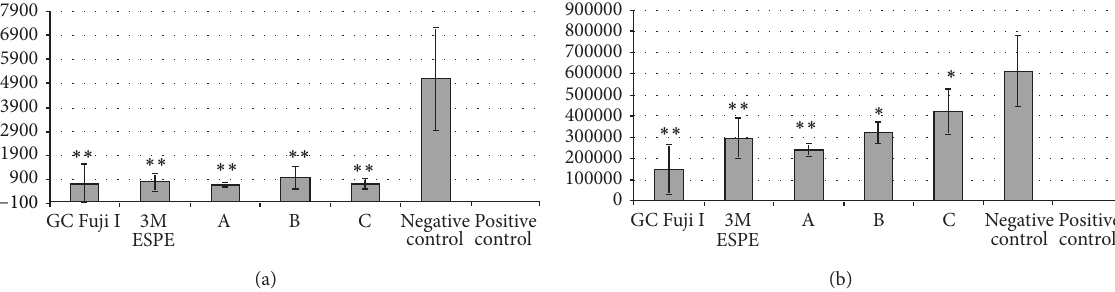
Figure 2: Bacterial count [CFU/mL] of adherent (a) and planktonic (b) bacteria after 4 h incubation of the different ionomer glass cement materials with log phase S. mutans . The materials were deposited for one week in sterile human saliva before testing. The 𝑦 -axis shows the CFU/mL.